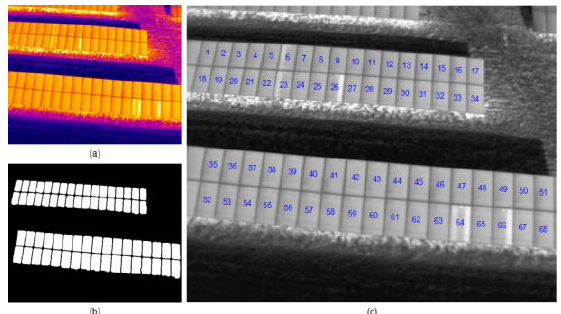
Figure 1. (a) Sample thermal infrared image (www.kiwata.de), (b) Panel area extraction result, and (c) Grayscale image with PV module numbers labelled